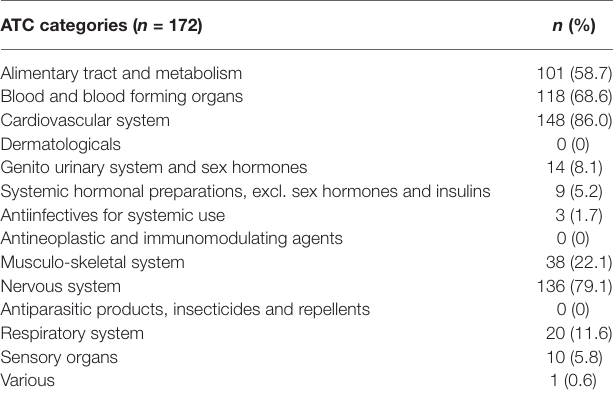
TABLE 2 | Frequencies of consumed drugs according to ATC classification